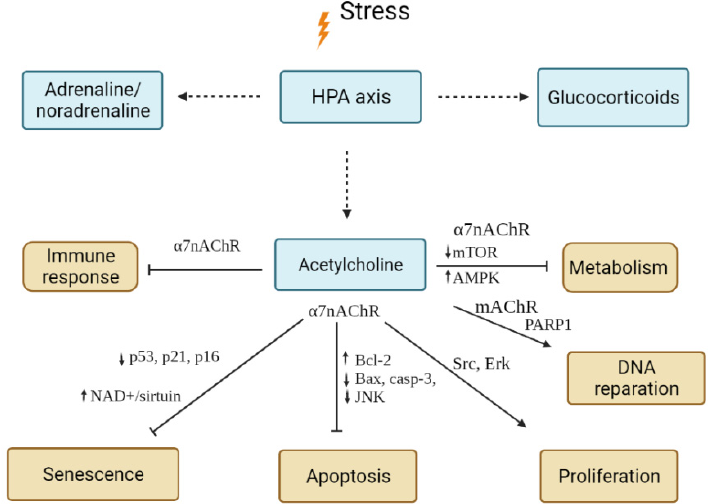
Figure 4. Schematic representation of effects of acetylcholine, the parasympathetic system neuro- transmitter, on intracellular processes and signalling pathways related to senescence, apoptosis, and cell cycle regulation. ↑ —stimulation, ↓ —inhibition, α 7nAchRs— α 7-nicotinic acetylcholine receptors, mAChR—muscarinic acetylcholine receptors.